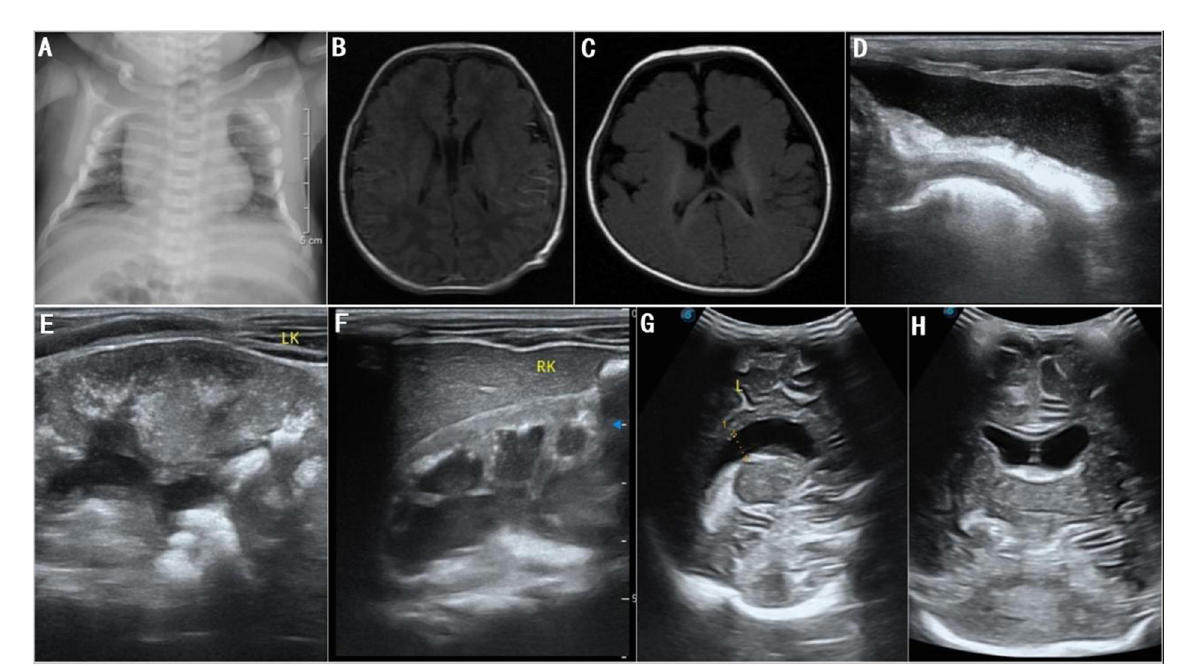
FIGURE3 (A) Chest radiographs at 3 days after birth show broad bones from the 2 nd to the 5 th pair of anterior ribs and thoracic deformity; (B) brain MRI at 5 days after birth shows normal lateral ventricles; (C) brain MRI at 6 months after birth shows normal lateral ventricles; (D–F) color Doppler ultrasonography at 18 months after birth shows bilateral hydronephrosis, and deposition of calcium in bilateral renal parenchyma, bilateral renal pelvises, and bladder; (G,H) color Doppler ultrasonography at 18 months after birth shows widened bodies and anterior horns of lateral